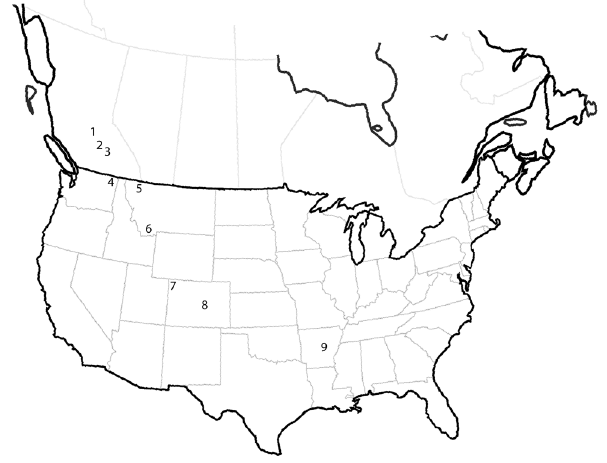
Fig 1 . Eocene fossil sites containing insects: (1) Horsefly (sites 1 – 4 are all Okanagan Highlands), (2) McAbee, (3) Falkland, (4) Republic, (5) Kishenehn, (6) Ruby River, (7) Green River (There are several Green River localities; shown is the Piceance Creek Basin site where most ant fossils have been collected), (8) Florissant, (9) Malvern (amber